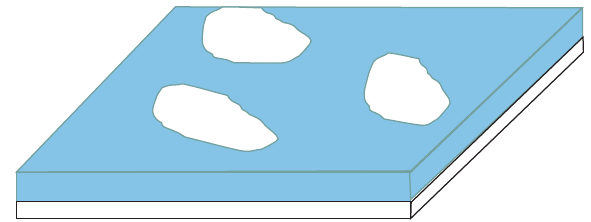
Figure 1: Damping treatments with a shape of H ( ϕ